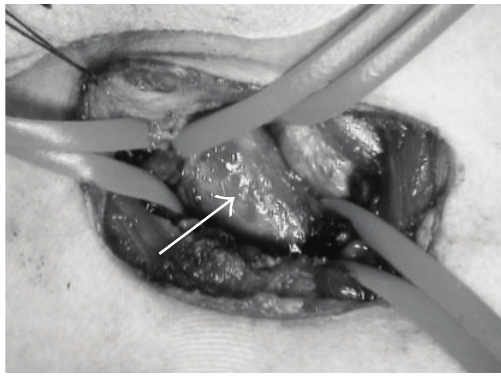
Figure 5: Intraoperative view. The innominate artery (white arrow) was isolated and taped proximally and